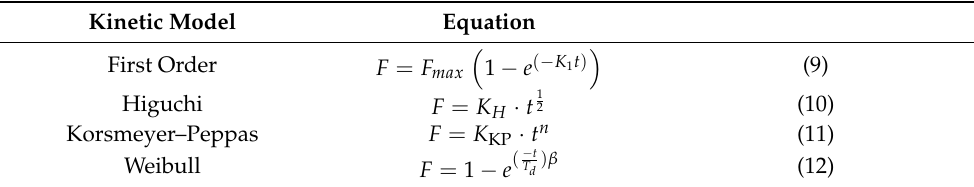
Table 2. Release equations used to evaluate the prepared